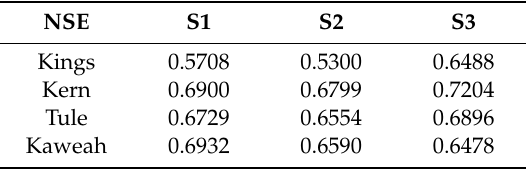
Figure 6. Comparisons of the predicted daily SWE for the three calibration scenarios for a typical snow-dominated sub-watershed in each of the four upland watersheds for the years 2001–2013. ( A – D ) Plots show the comparisons of the SWE at the sub-watershed levels for the Kings, Kern, Tule, and Kaweah watersheds. ( E – X ) Plots show the comparisons of the daily predicted SWE for each of the five elevation bands (EB1–EB5) in the selected sub-watersheds shown in Figure 5 for the four watersheds. NOD refers to the Number of Days. Table 4. SWE Nash-Sutcliff Efficiencies for all three scenarios for the typical sub-watersheds in each watershed.